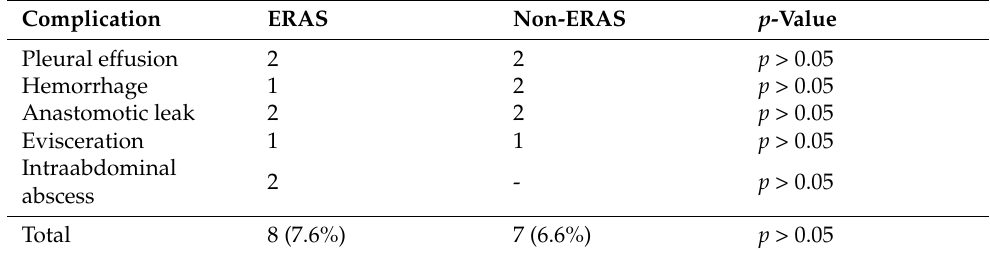
Table 4. Post-operative complications by Clavien–Dindograde